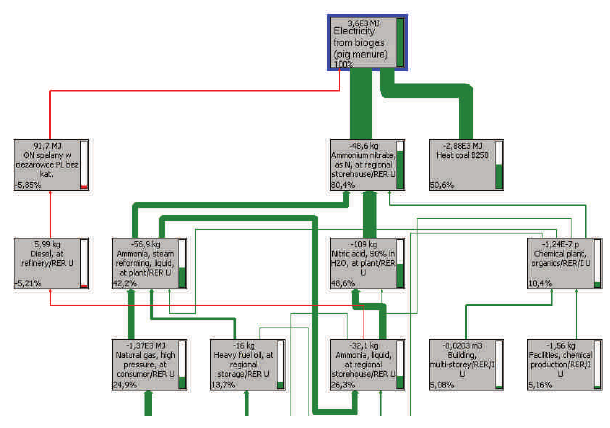
Fig. 5. Sankeya graph for 1 MWh of electricity production biogas obtain from pig slurry, distillery slop and sugar beet pulp ((material-energy balance fragment)